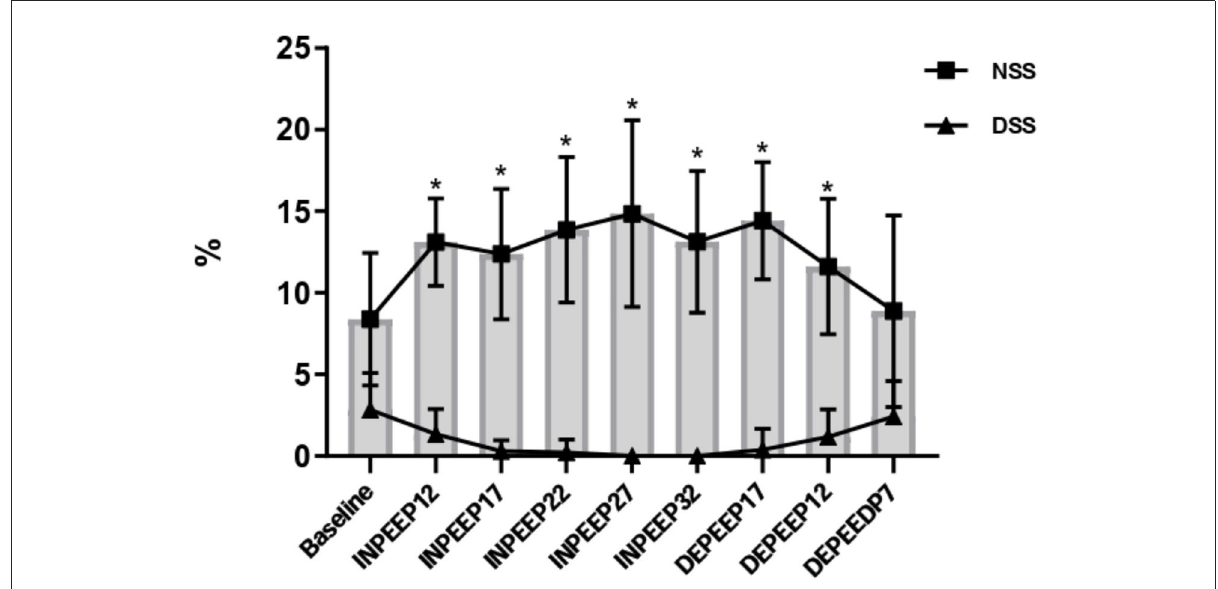
FIGURE3 Variation of the non-dependent (closed square) and dependent (closed triangle) silent space region of lung represented by mean ± standard deviation during recruitment maneuver for PEEP titration. NSS: non-dependent silent space; DSS: dependent silent space. PEEP: positive end-expiratory pressure; Baseline: 7 cmH 2 O of PEEP; INPEEP12: PEEP 12 cmH 2 O increase; INPEEP17: PEEP 17 cmH 2 O increase; INPEEP22: PEEP 22 cmH 2 O increase; INPEEP27: PEEP 27 cmH 2 O; INPEEP32: PEEP 32 cmH 2 O increase; DEPEEP17: PEEP 17 cmH 2 O decrease; DEPEEP12: PEEP 12 cmH 2 O decrease; DEPEEP7: PEEP 7 cmH 2 O decrease. * Statistically significantly different from the